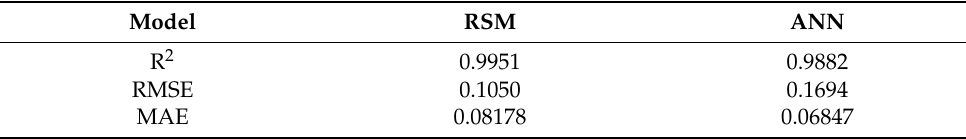
Figure 6. Comparison between the predicted values of RSM and ANN models and the experimental values of demulsification percentage. Table 6. Comparison of RSM and ANN demulsification percentage